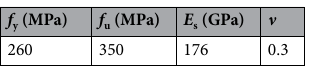
Table 2. Mechanical performance of steel.